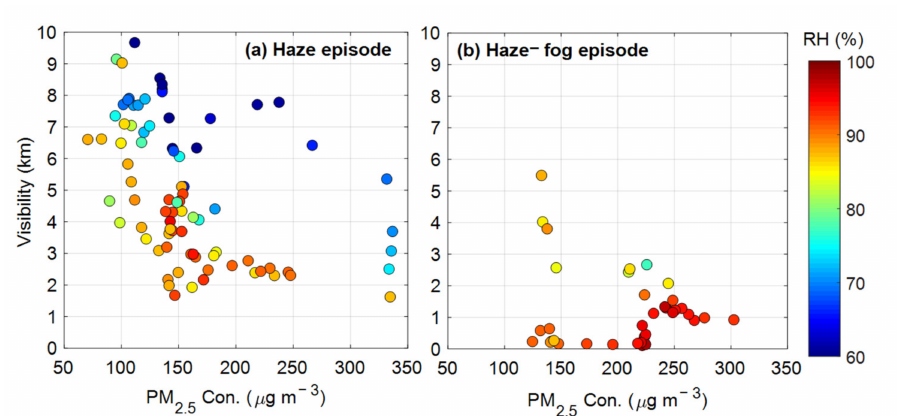
Figure 4. Relationship between measured hourly mean visibility and PM 2.5 mass concentration under different RH conditions for the ( a ) haze and ( b ) haze–fog mixed episodes in Shenyang on 22–27 January